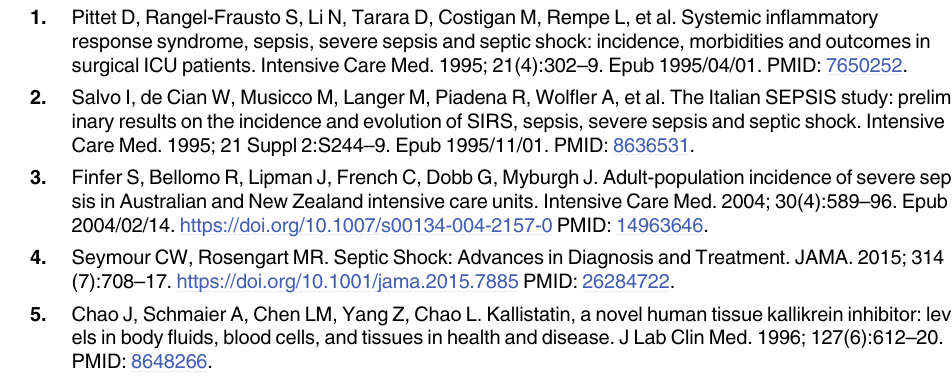
S1 Table. Comparisons of day 1 plasma biomarkers between severe sepsis and septic shock, ARDS and non-ARDS, and positive blood culture and negative blood culture. S2 Table. Cox univariate and multivariable analysis for 60-day mortality in patients with severe sepsis and septic shock. S3 Table. Univariate and multivariable analyses for factors independently associated with septic shock, ARDS, and positive blood culture in patients with severe sepsis and septic